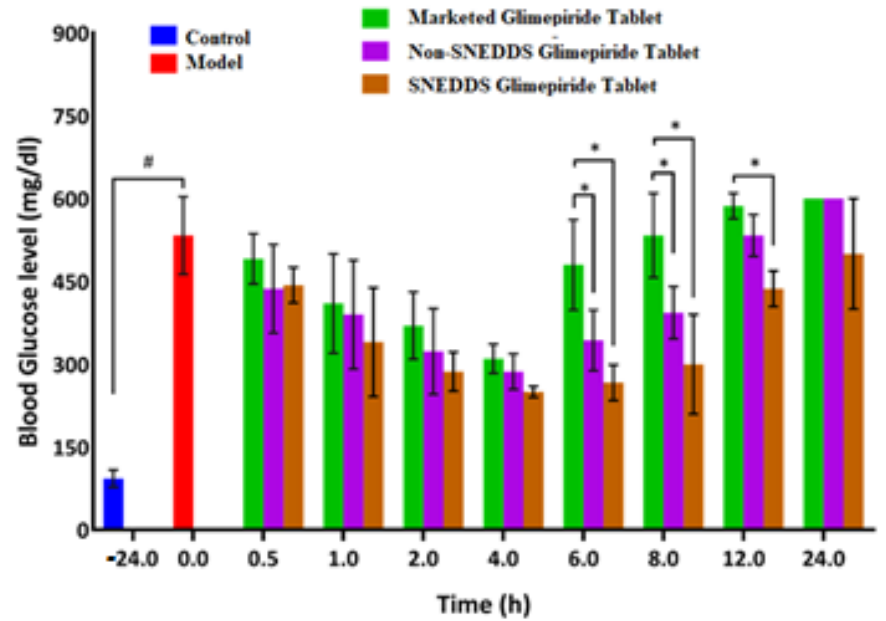
Figure 9. Blood glucose level after oral administration of the SNEDDS, non-SNEDDS, and marketed glimepiride tablets to induced-hyperglycemic male Wistar rats ( n = 6). Notes: # Indicates significance from the control group, * Indicates significance from marketed tablets. Significant difference was considered at p < 0.05. Data are presented as mean ± SD, ( n =